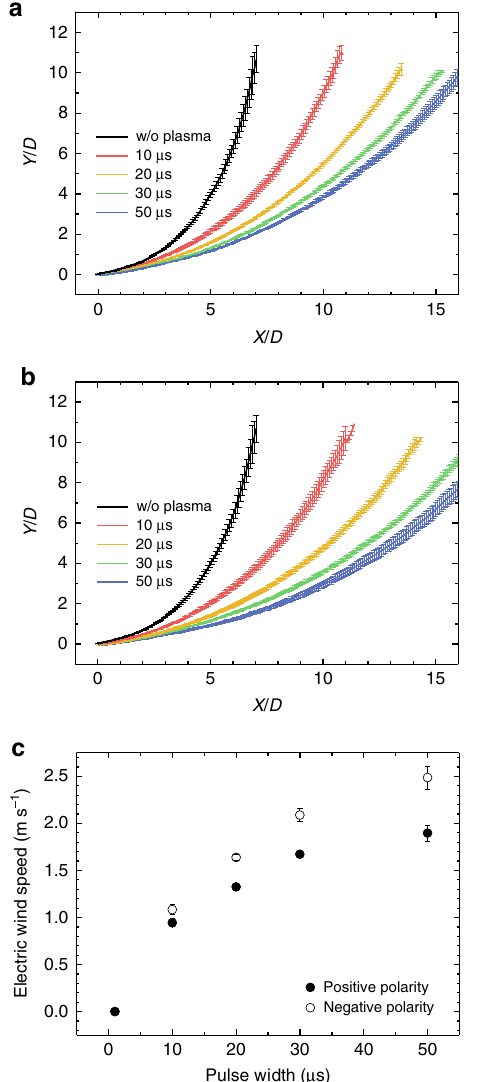
Fig. 4 Positive- and negative-polarity voltage pulses and their effects on the fl ow trajectory. The helium fl ow trajectories for a positive-polarity and b negative-polarity pulsed plasma jets with pulse widths of 10 – 50 μ s generated at 3 kV are presented. Corresponding results are generated with the voltage and current waveforms from Supplementary Fig. 5. The differences in the electric wind speeds for both polarity cases are depicted from c , which are the result of space charge species remaining behind the moving streamer head. Data are shown as mean ± s.d. for all panels; n =